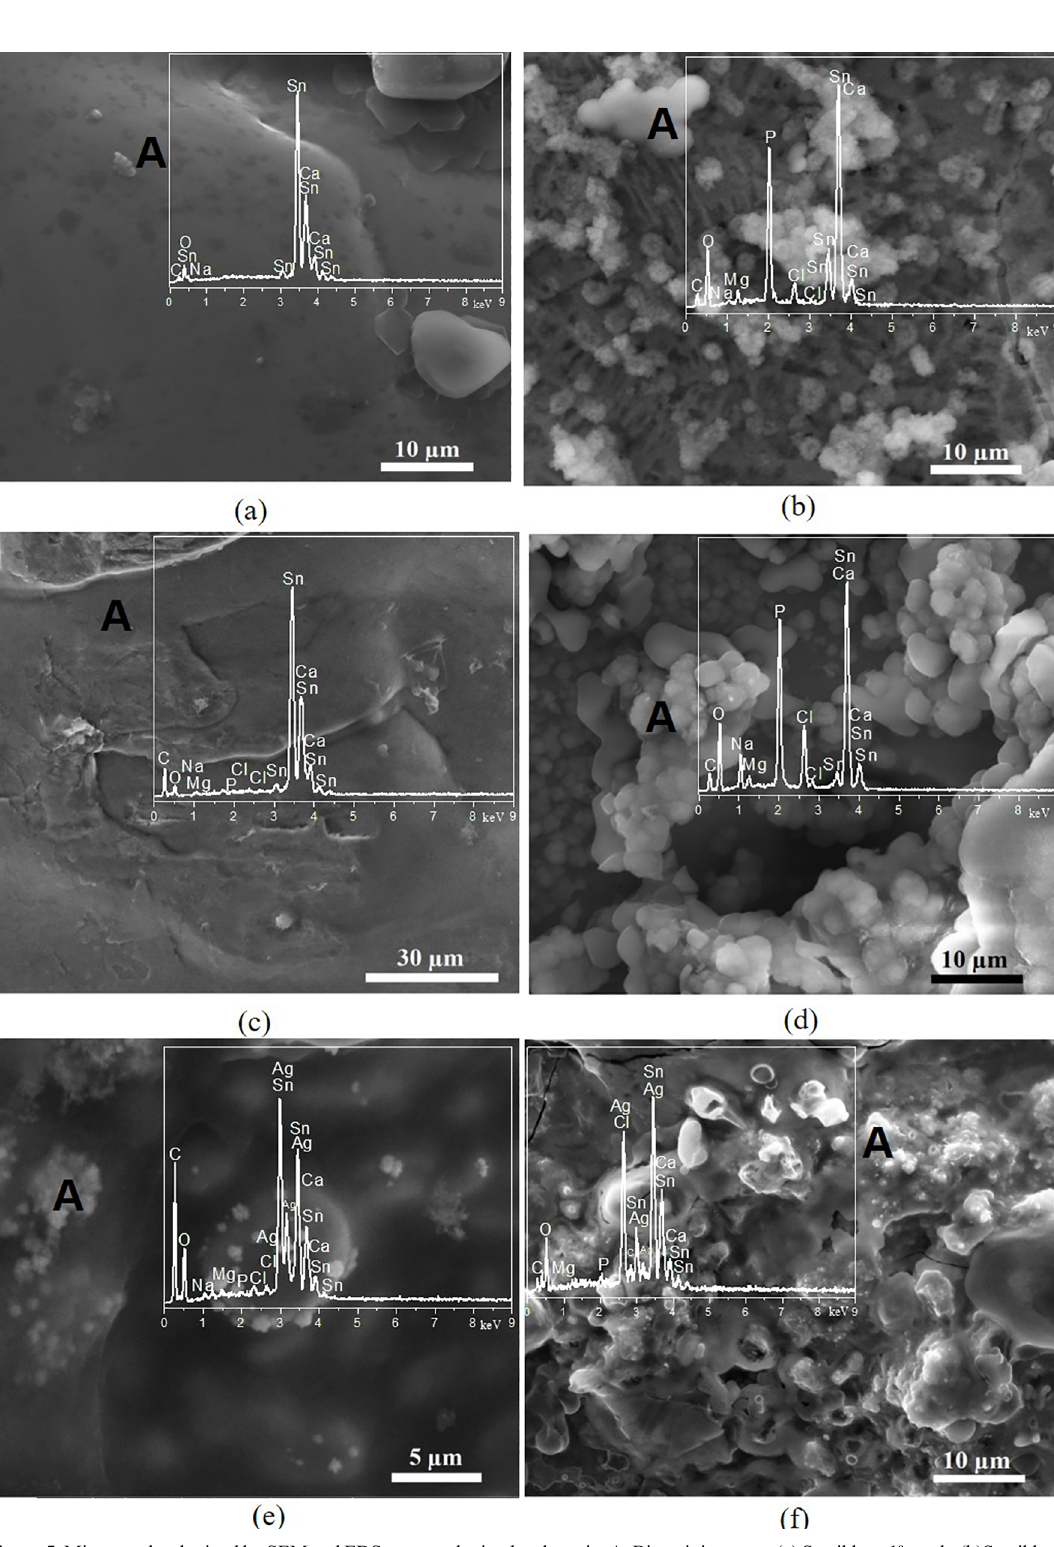
Figure 5. Micrographs obtained by SEM and EDS spectra obtained at the point A. Bioactivity essay. (a) Sn-ribbon-1ª week; (b)Sn-ribbon- 4ªweek; (c) Sn+PCL ribbon-1ªweek; (d) Sn+PCL ribbon-4ªweek; (e) Sn+PCL+NPAg-ribbon-1ªweek; (f)